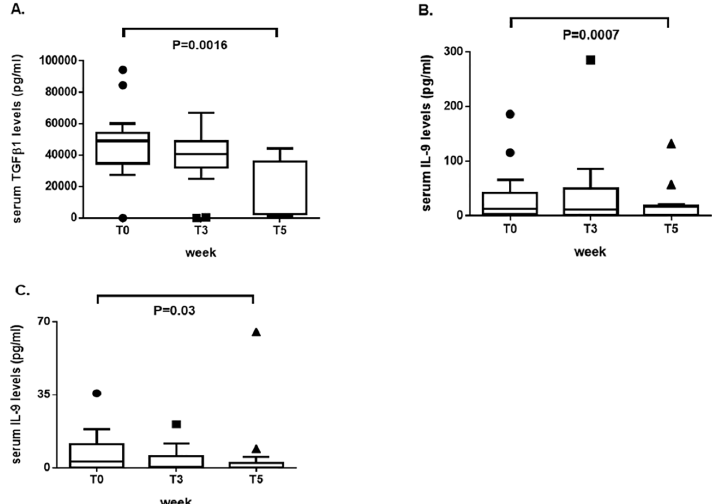
Fig 5. Levels (pg/ml) of pro-inflammatory/immunoregulatory cytokines measuredin the serum of patients with RA and SLE at the main timepoints of the study set at T0 (baseline, before starting the low-sodium dietary regimen), T1 (after 1 week, at the end of the “run-in” period of low-sodium dietary regimen), T3 (after 3 weeks, at the end of low-sodium dietary regimen), and T5 (at the end of the study, after 2 weeks of normal sodium dietary regimen). (A) Significant reductionin serum TGF β 1 levels and (B) IL-9 levels at T5 comparedto T0 in patients with rheumatoid arthritis. (C) Significant reductionin serum IL-9 levels in patients with systemic lupus erythematosus at T5 with respect to T0. Data are shown as Tukey boxplots; lines represent the medianlevel with 25 th -75 th percentile; data not includedbetweenthe whiskers are plotted as outliers with